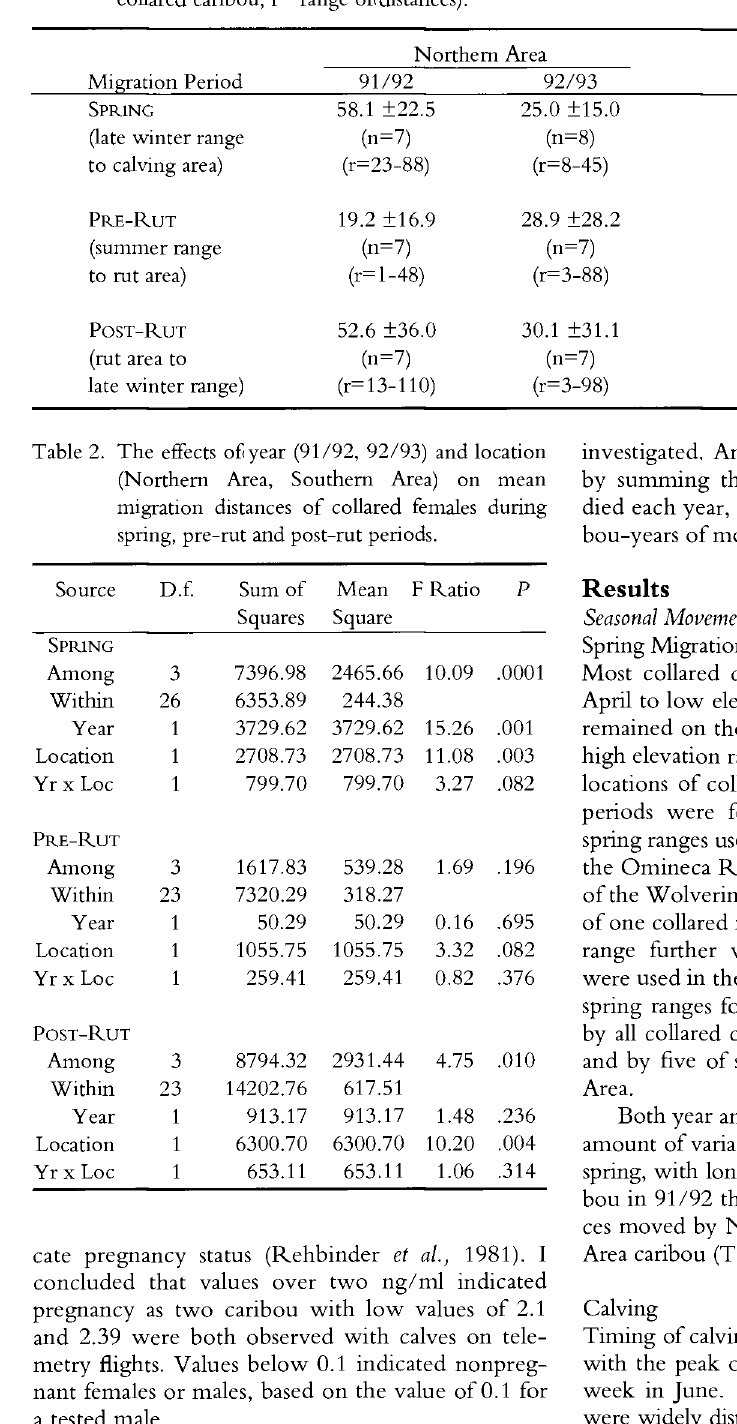
Table 1. Mean migration distances ±SD (km) of female radio-collared caribou between seasonal ranges. (n= number of collared caribou, r= range of distances).